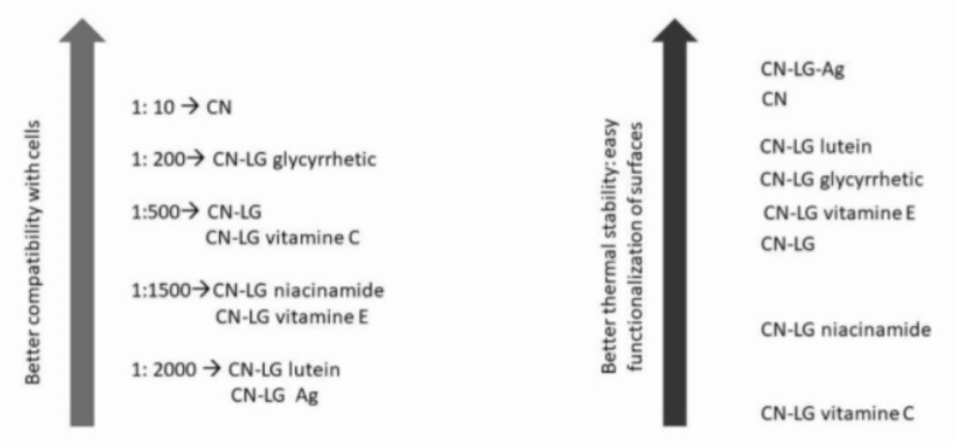
Figure 9. Increased compatibility and thermostability of CN–LG microparticles encapsulating different active ingredients.